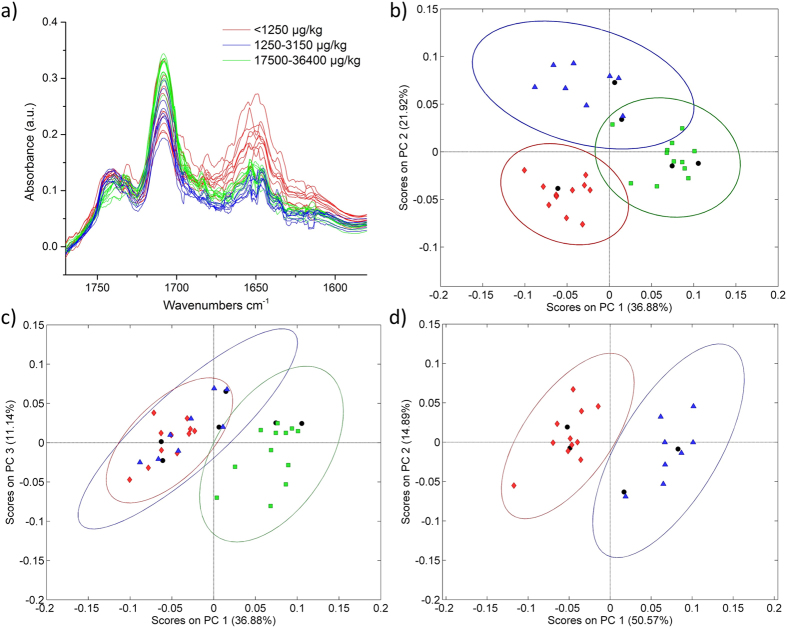
(a) QCL spectra (single wavelength sweeps) of 24 maize extracts with different DON contamination levels. PCA score plots of QCL spectra (1770–1580 cm−1) of maize with various DON contamination ranges (<1250 μg kg−1, red; 1250–3150 μg kg−1, blue; 17500–36400 μg kg−1, green). (b) PC1 vs PC2, and (c) PC1 vs PC3 of the entire dataset. (d) PCA of a reduced dataset, where samples with contaminations well above the EU regulatory limits were excluded. Validation samples are indicated as black dots.